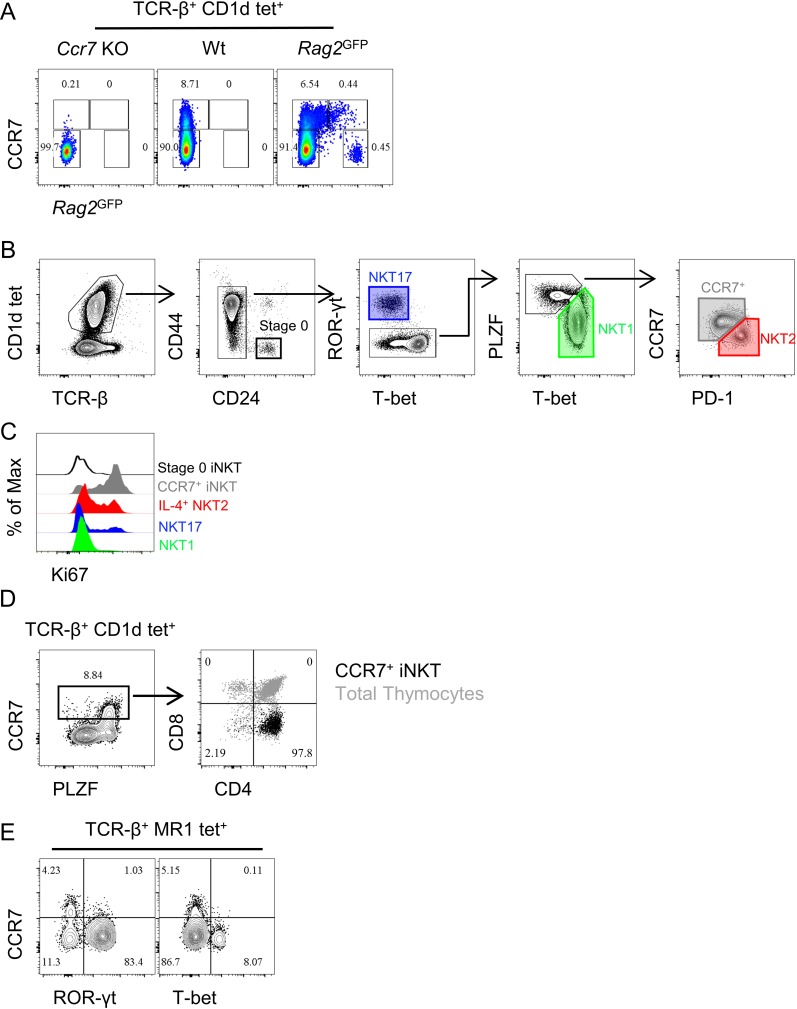
Specific CCR7 staining in iNKT cells and gating strategy of iNKT subsets and CD4/CD8 profile of CCR7+ iNKT and CCR7+ MAIT cells.(A) Representative flowcytometry profile of CCR7 staining in thymic iNKT cells enriched from Ccr7−/−, Wt and Rag2GFP mouse. (B) Gating strategy to identify enriched thymic iNKT cells as well as various subpopulations of iNKT cells, stage 0 iNKT (heavy black line), CCR7+ iNKT (grey polygon), NKT1 (green polygon), NKT2 (red polygon) and NKT17 cells (purple rectangle). (C) Representative staining of Ki67 in various subpopulations of iNKT cells, stage 0 iNKT (black), CCR7+ iNKT (grey), NKT1 (green), NKT2 (red) and NKT17 cells (purple). Data are representative of three independent experiments with 2–3 mice in each. (D) CD4/CD8 profile of thymic CCR7+ iNKT cells. Identification of CCR7+ cells in enriched thymic iNKT cells (left column), and CD4/CD8 profile of CCR7+ iNKT cells (black dots) relative to the total thymocytes (grey dots) from the same mouse (right column). Number indicates percent cells in each gate. (E) Expression of T-bet and ROR-γt with CCR7 in thymic MAIT cells (TCR-β+ CD1d-PBS57+). Data are representative of 2 independent experiments with 2 mice in each.